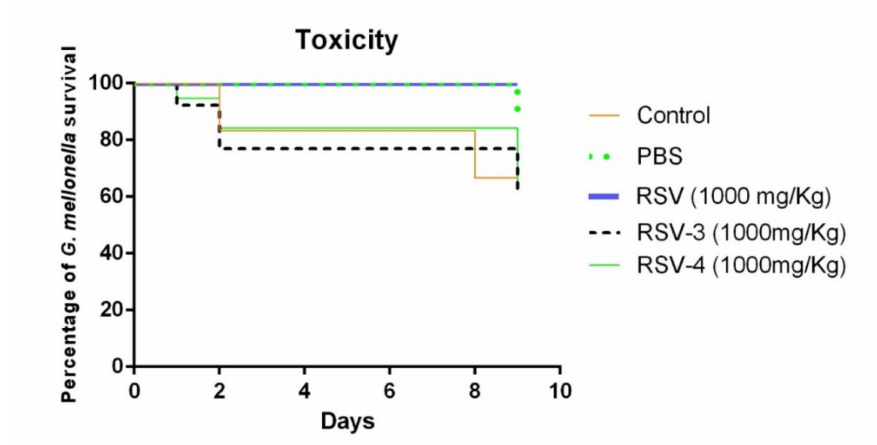
Figure 5. Survival of Galleria mellonella larvae in the presence of PBS, RSV, RSV-3, RSV-4 for 9 days, for the toxicity